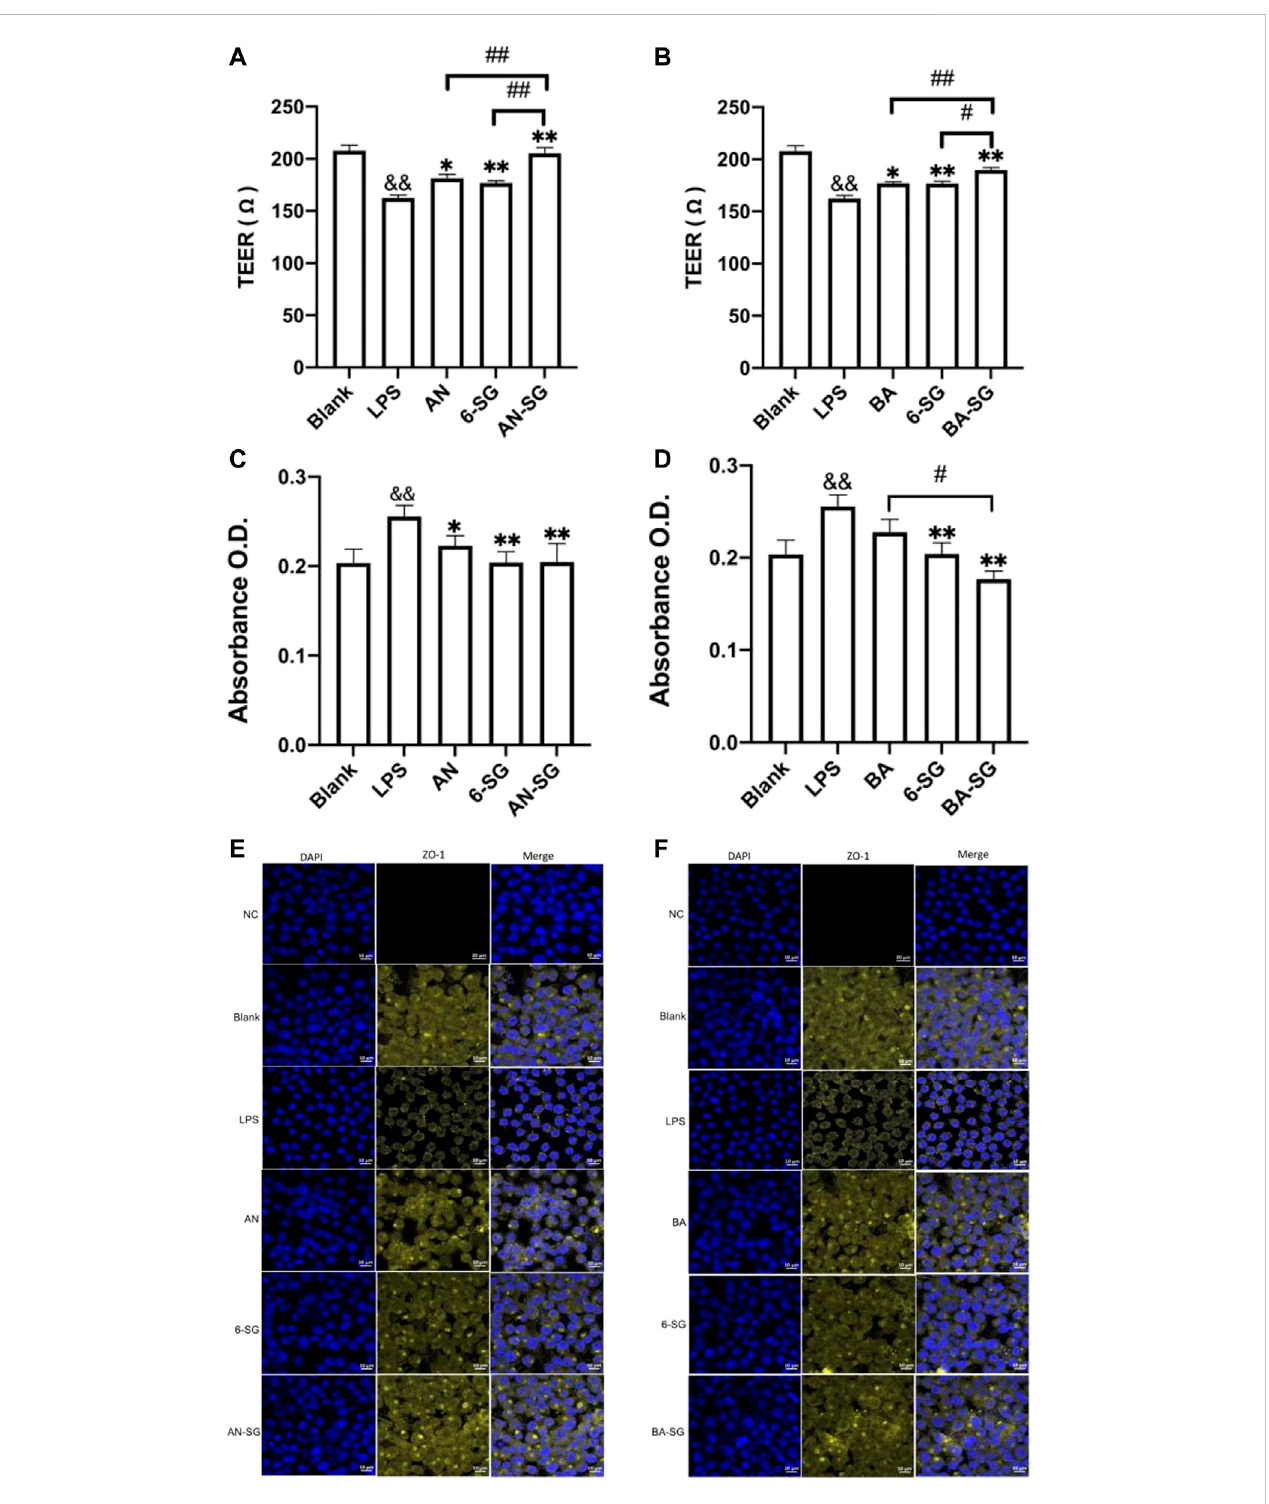
AN-SGandBA-SGdemonstratedamoreprominenteffectinprotectingtheendothelialtightjunctionofMVECcellsinthetri-culturesystemagainstLPS- stimulated neuroin fl ammation. The measurements of TEER (A) , Evans blue absorbance (C) and tight junction protein ZO-1 (E) for AN-SG, and TEER (B) , Evans blue absorbance (D) and tight junction protein ZO-1 (F) for BA-SG in the LPS-activated tri-culture model. Immuno fl uorescence staining of ZO-1 in the MVEC cells of the tri-culture model. Images were taken using a confocal microscope with ×63 magni fi cation. Blue: DAPI in the nucleus; yellow: ZO-1 in the microvascular endothelial cells. Scale bar = 10 μ m && p < 0.01 vs. Blank, * p < 0.05, ** p < 0.01 vs. LPS, # p < 0.05, ## p < 0.01 vs. combination, by one-way ANOVA analysis and Tukey test for group comparison in GraphPad Prism 9. O.D.: optical